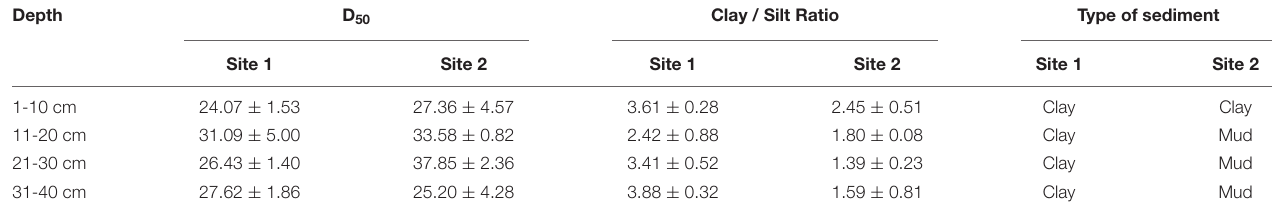
TABLE 2 | Grain sizes at different sediment depths at the two study sites in the Yellow River Delta.